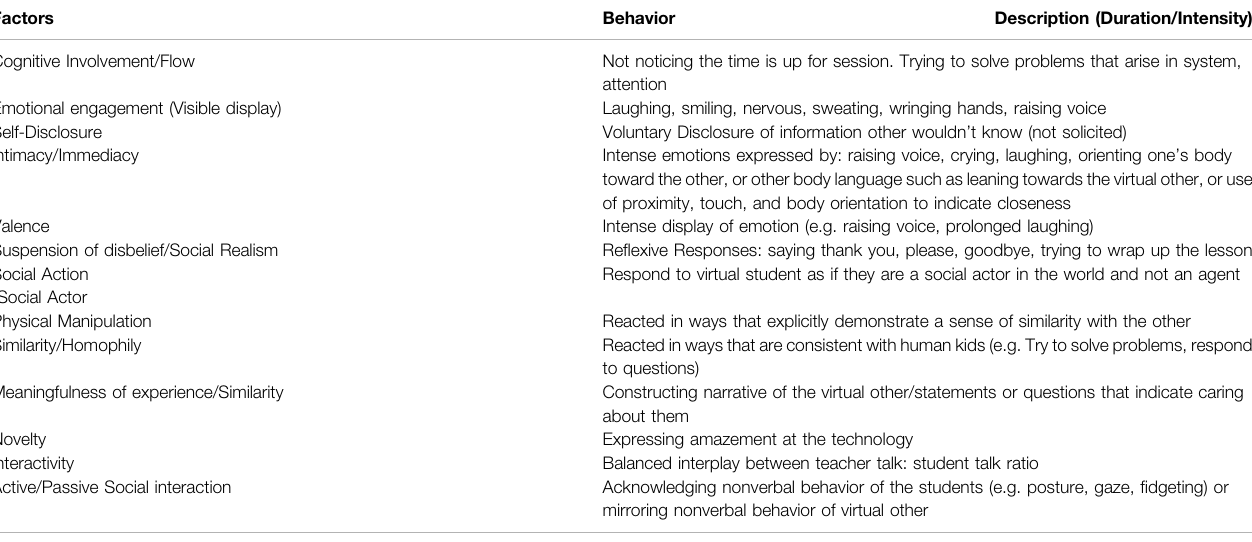
TABLE 3 | Behavioral coding system for social presence.